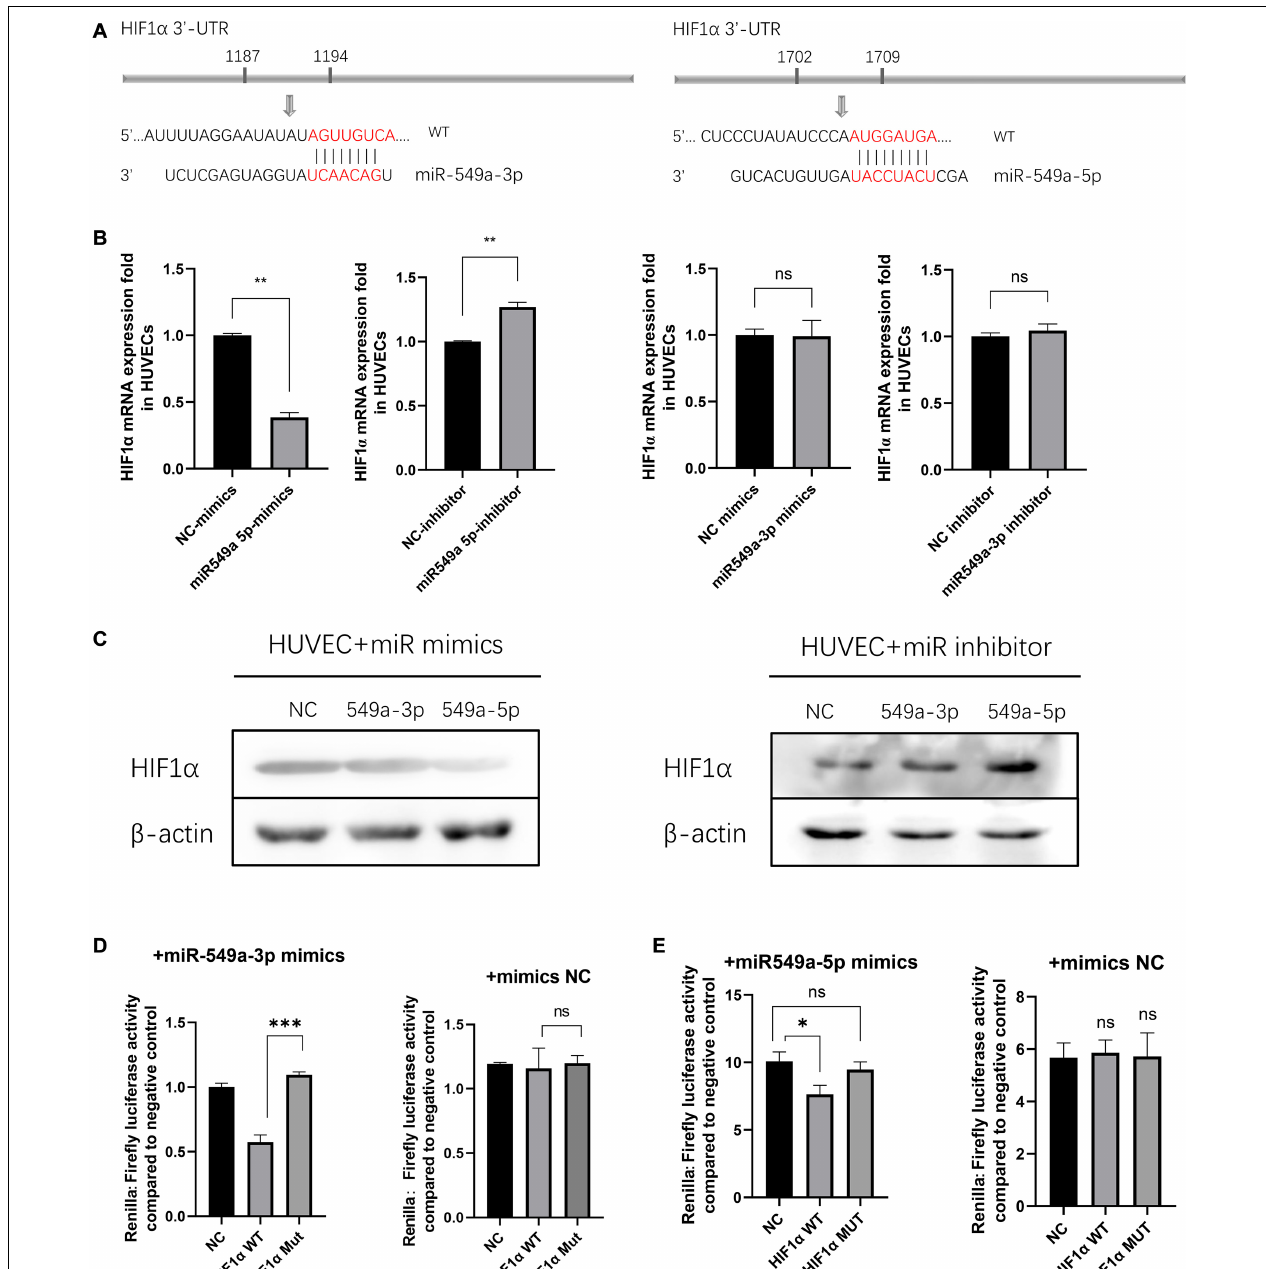
FIGURE 6 | miR-549a silences HIF1 α in HUVECs. (A) The miR-549a-3p and miR-549a-5p binding sites in the 3 (cid:48) -UTR of HIF1 α were predicted. (B) RT-PCR analysis of HIF1 α RNA expression in HUVECs treated with miR-549a-3p/miR-549a-5p mimics or inhibitor. (C) Western blot analysis of HIF1 α expression in HUVECs treated with miR-549a-3p/miR-549a-5p mimics or inhibitor. (D,E) Dual-luciferase reporter gene assay showed that miR-549a-3p/miR-549a-5p inhibited the luciferase activity of reporter containing wild-type but not mutant 3 (cid:48) -UTR of HIF1 α . Mean ± SEM are provided ( n = 3). * P < 0.05, ** P < 0.01, *** P < 0.001; ns, not significant according to two-tailed Student’s t